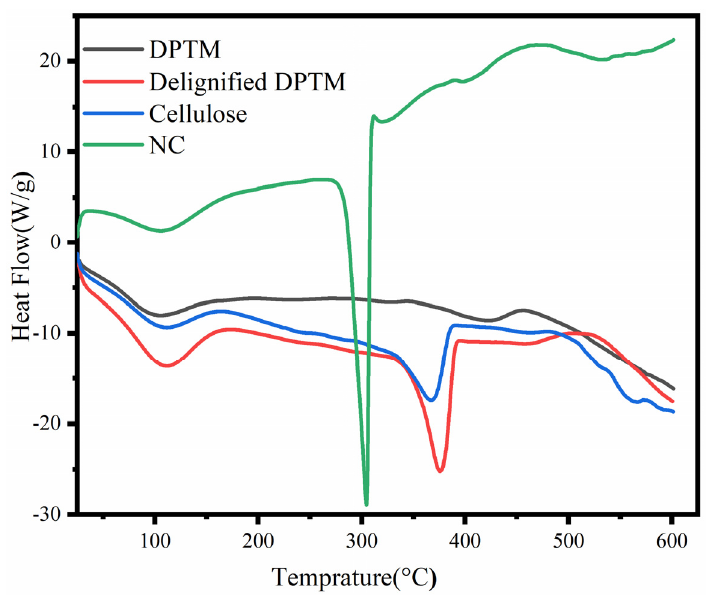
Figure 4. DSC curve of DPTM, delignified mesh, cellulose and nanocellulose samples.